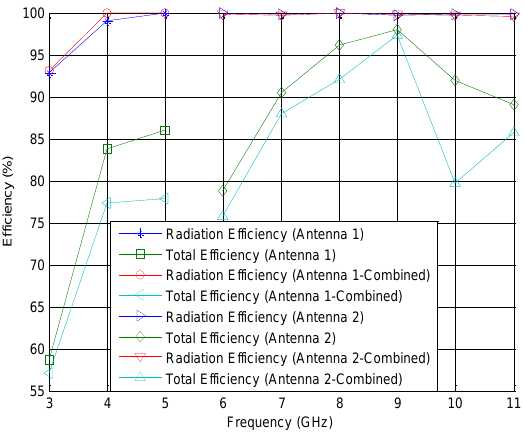
Fig. 16 : Efficiency of the